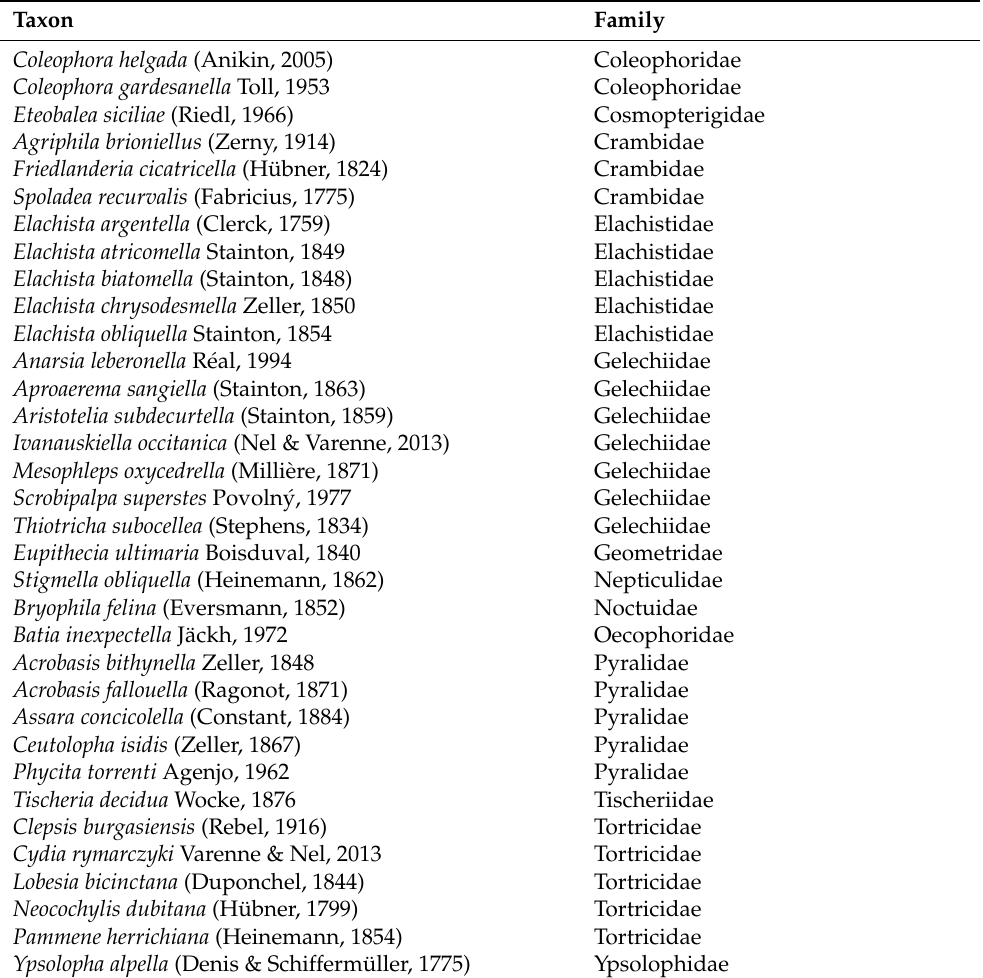
Table 1. New faunistic records for